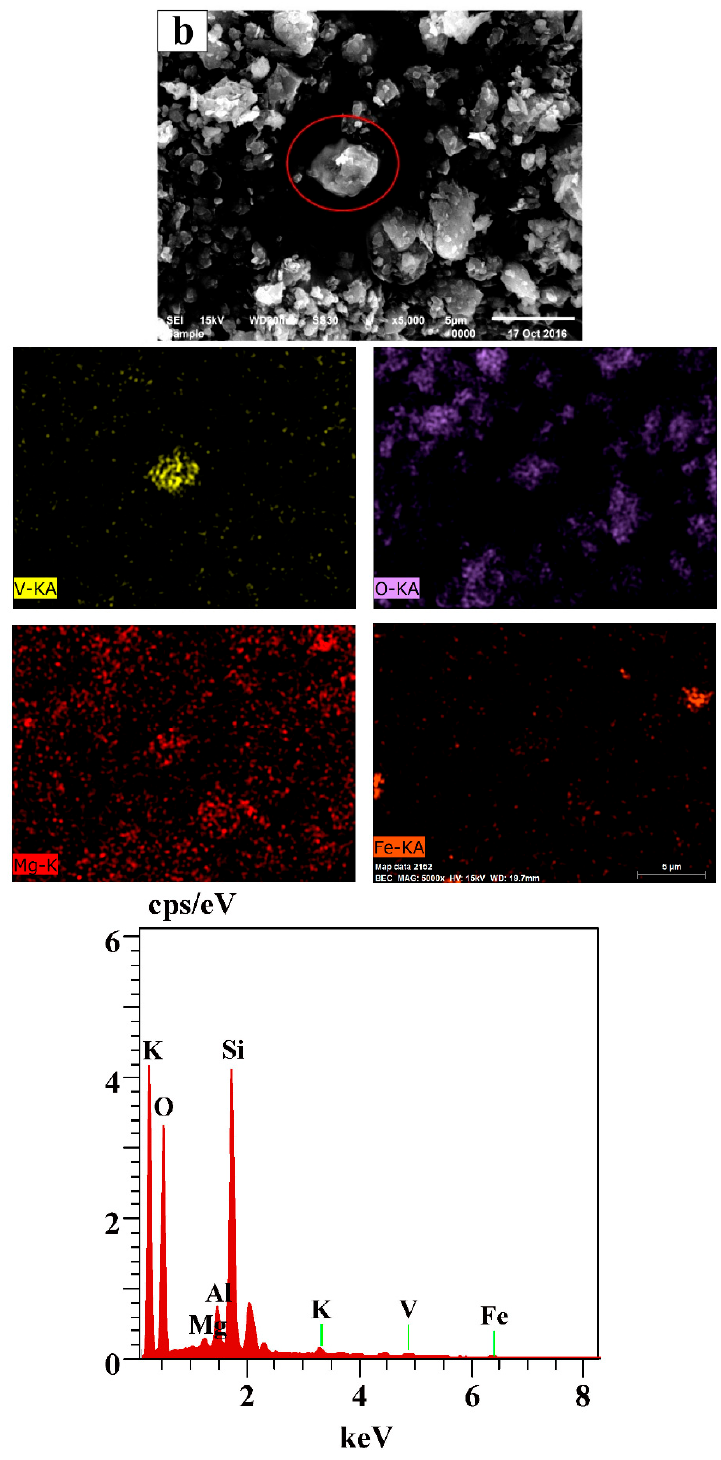
Figure 10. SEM images and corresponding EDS analysis of the blank roasted sample ( a ) and the sample roasted with 3 wt % MgO ( b ) at 500 °C.